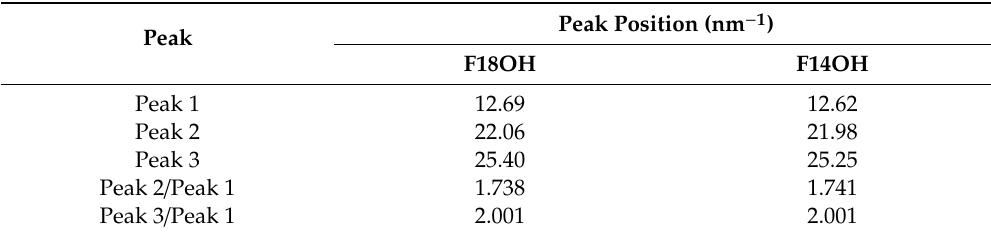
Table 4. Positions of the di ff raction peaks and ratios of the positions of selected pairs of peaks, obtained for the simulated spectra presented in Figure